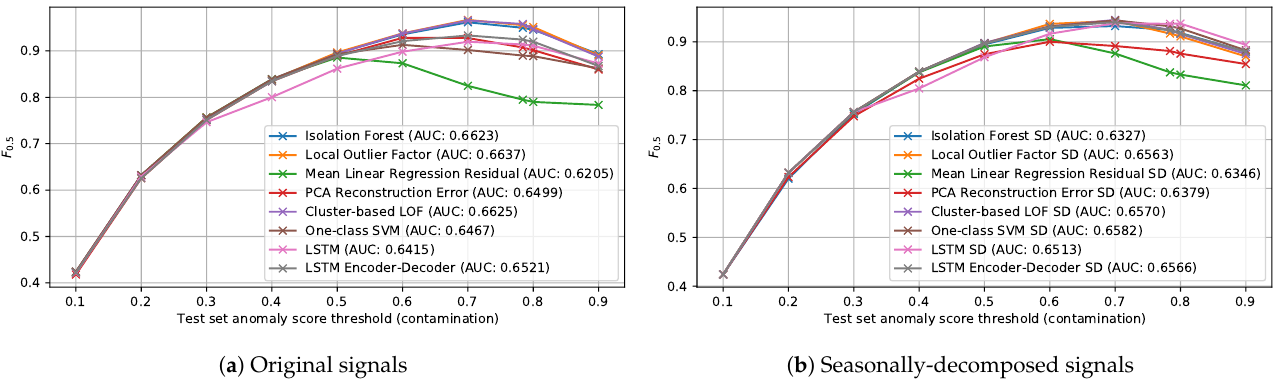
Figure 16. F 0.5 of the detection methods for different thresholding contamination